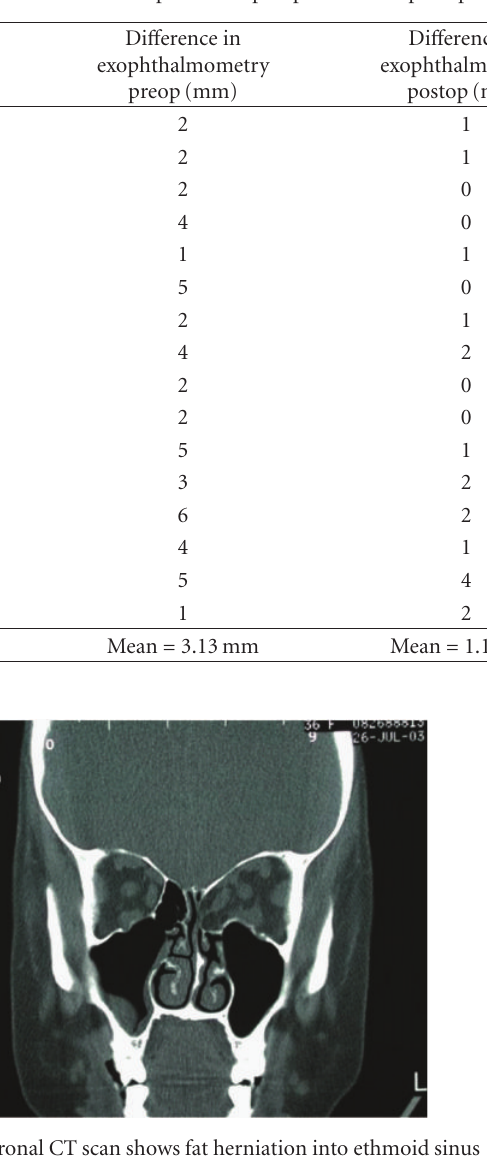
Table 2: Comparison of preoperative and postoperative exophthalmometry and diplopia in primary gaze.